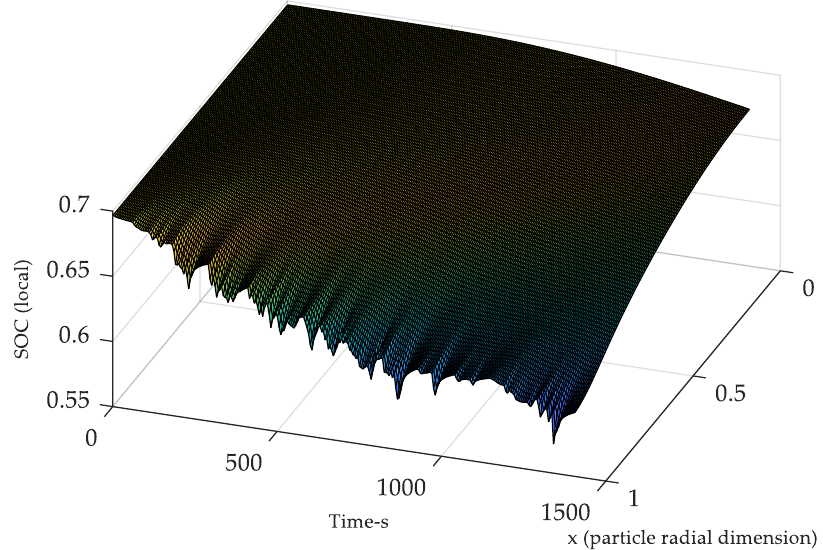
Figure 9. Temporal and spatial distribution of iSOC inside the electrode particle during the CITY test at 25 °C ambient temperature.